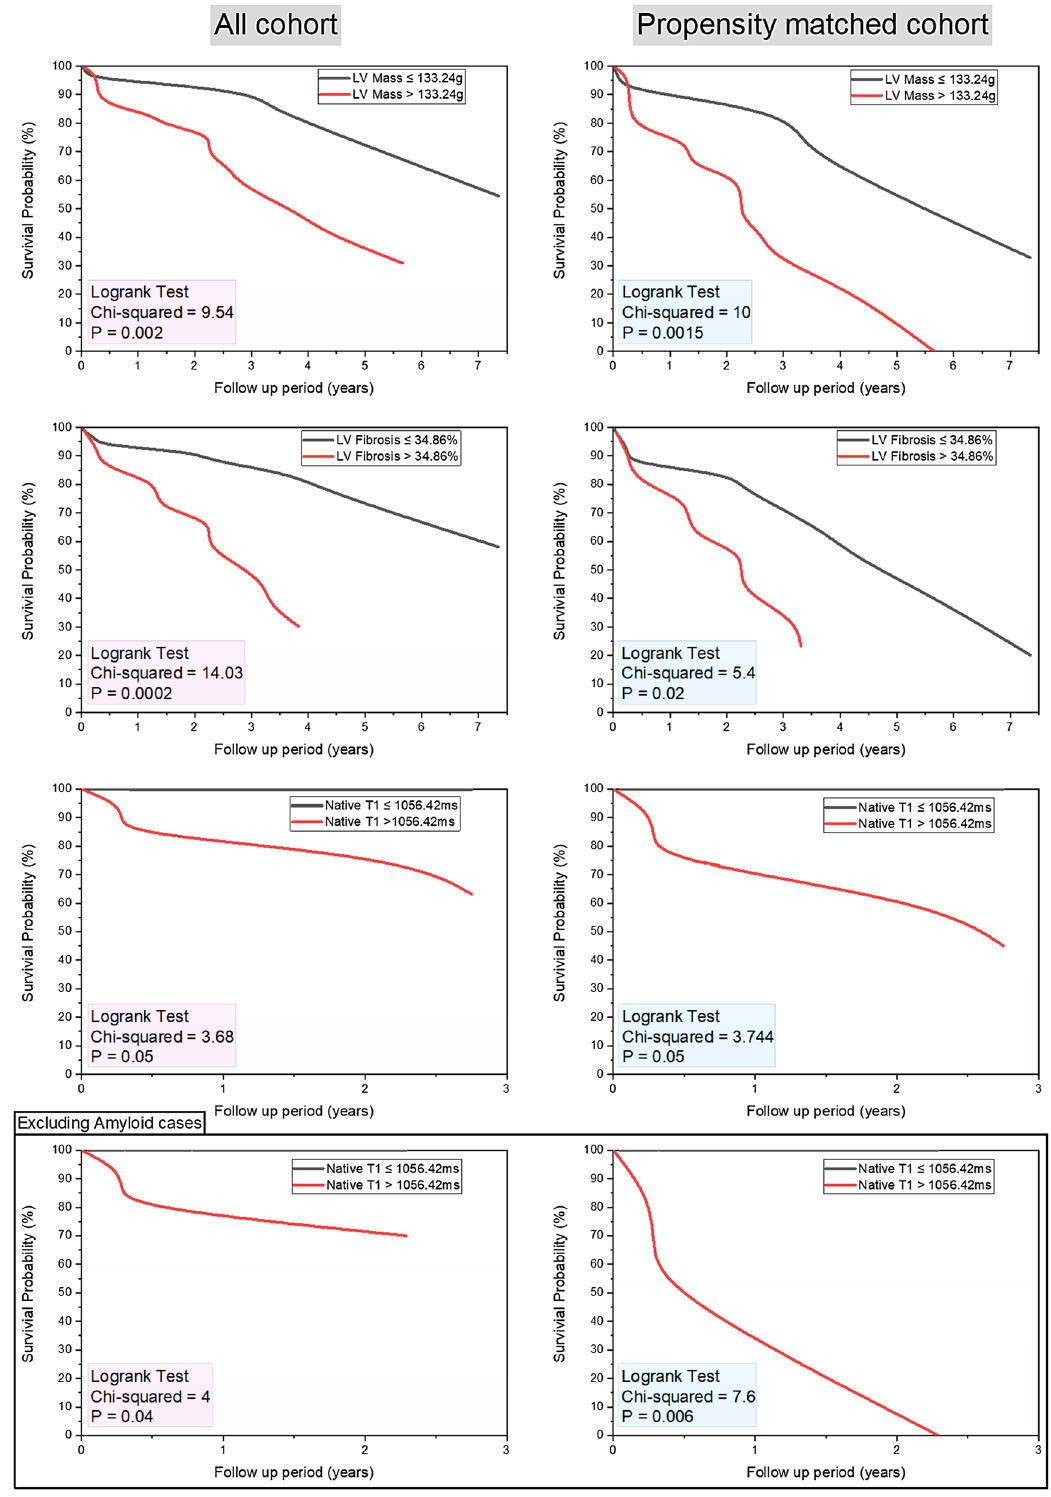
Figure 3. Kaplan–Meier survival analysis for variables associated with all-cause mortality. All cohort data is on the left-sided panel and the propensity matched cohort on the right-sided panel. In non-amyloid cohort, it was only native T1, which demonstrated prognostic